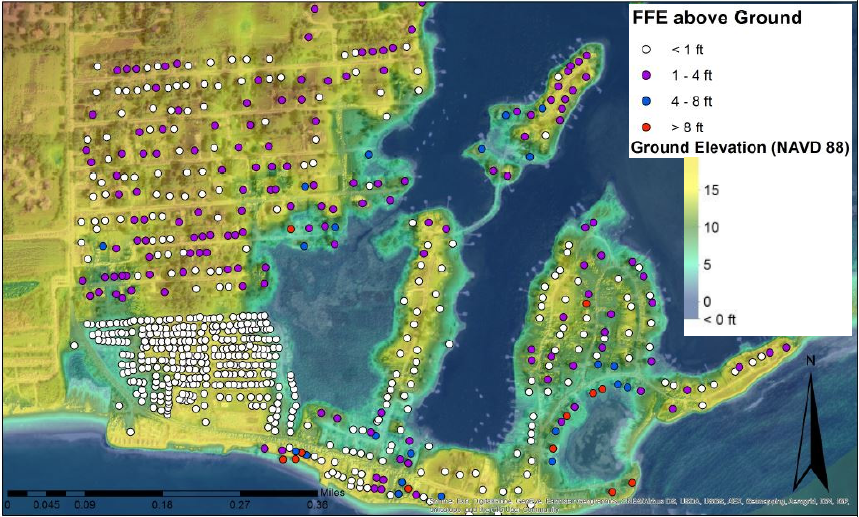
Figure 7. Values of Furnished Floor Elevation (FFE) for each structure and topography within the study area.